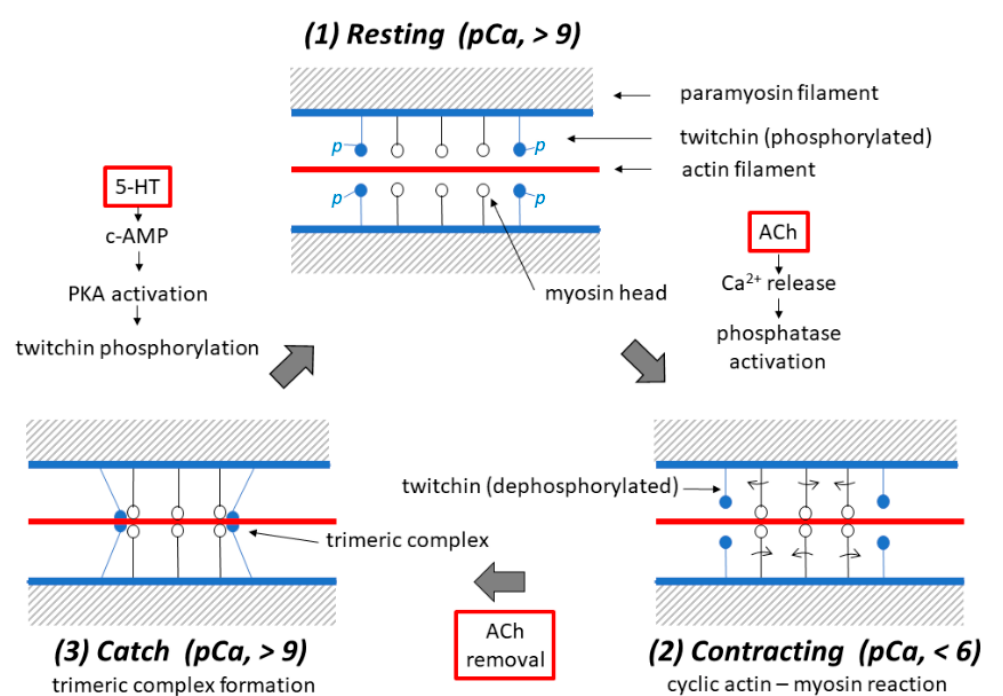
Figure 10. Schematic diagrams illustrating possible mechanisms underlying the three different states, i.e., the (1) resting, (2) contracting and (3) catch states in the ABRM fibers. Each diagram shows a pair of adjacent thick filaments (with a paramyosin core), around which both myosin (with myosin heads extending laterally) and twitchin (with oval-shaped projections colored blue) are bound to face the actin filament (colored red). (1) In the resting ABRM fibers, twitchin is in the phosphorylated state, while t he [Ca 2+ ]i in the myoplasm is low (pCa, >9) to inhibit actin–myosin interaction. (2) Upon ACh application, it causes Ca 2+ release from the intracellular structures, and the resulting increase in [Ca 2+ ]i (pCa, <6) produces cyclic actin–myosin interaction to put the ABRM fibers into the contracting state. (3) After ACh removal, [Ca 2+ ]i decreases to the resting level due to Ca 2+ reuptake by the intracellular structures, and dephosphorylated twitchin forms a trimeric complex with actin and myosin to build up the catch state. Application of 5-HT induces c-AMP-dependent protein kinase A (PKA) activation, which in turn causes twitchin phosphorylation to result in the disappearance of the trimeric complex, and the ABRM fibers return to the resting state.